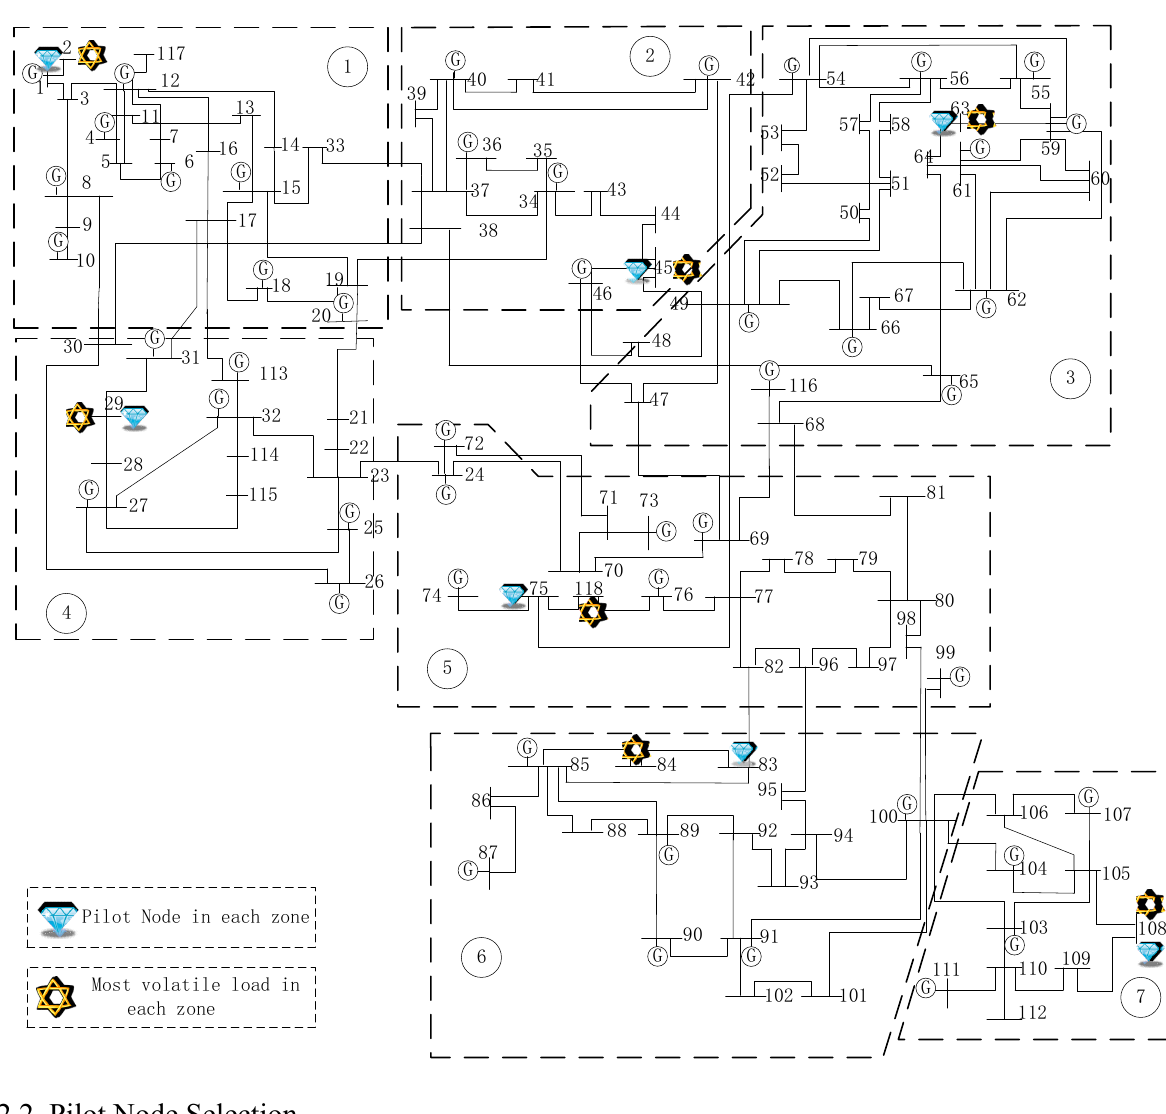
Figure 8. IEEE 118-bus system and the partition